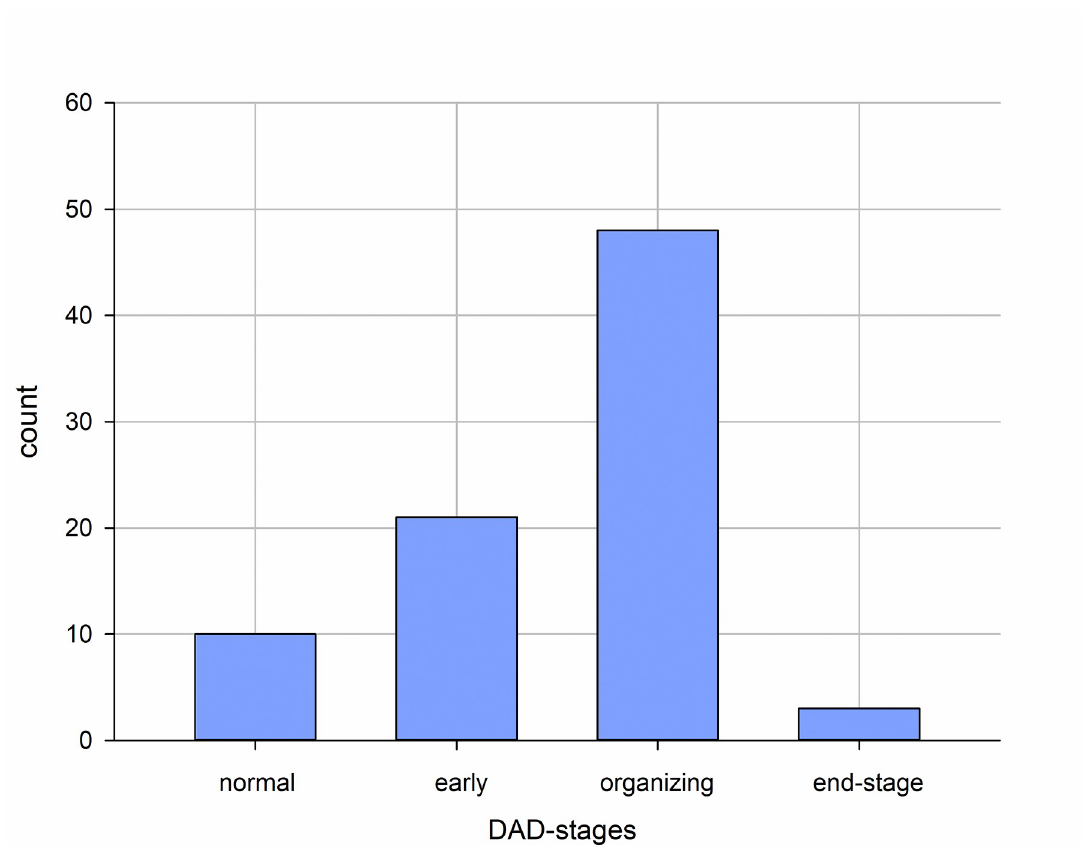
Fig 1. Distribution of DAD based on 83 samples from 19 patients. DAD = diffuse alveolar